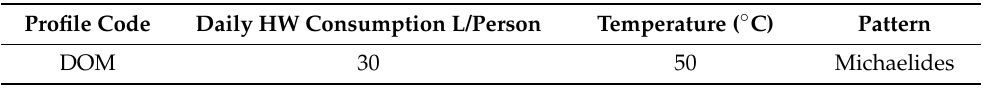
Table 4. Consumption profile of the validation study.